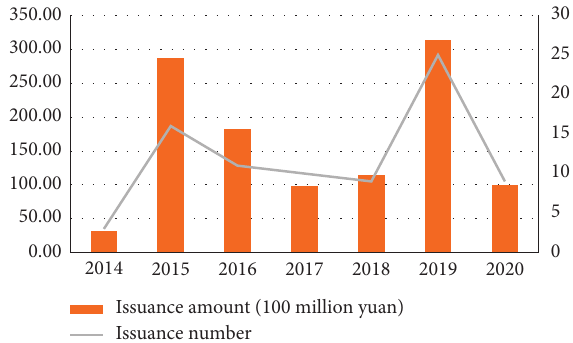
Figure 1: Supply chain ABS issuance (100 million